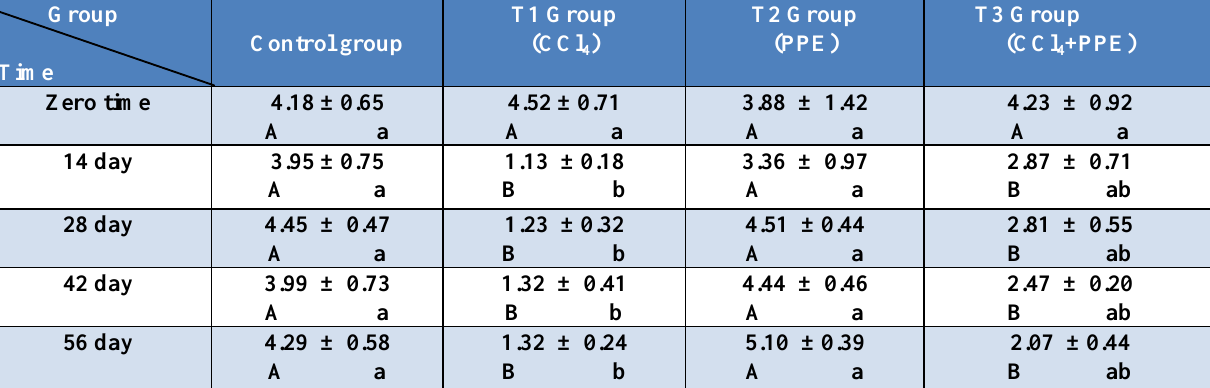
Table ,1: Effect of CCl (ng/ml) in adult male rabbit. M ± S.E. (n = 6).